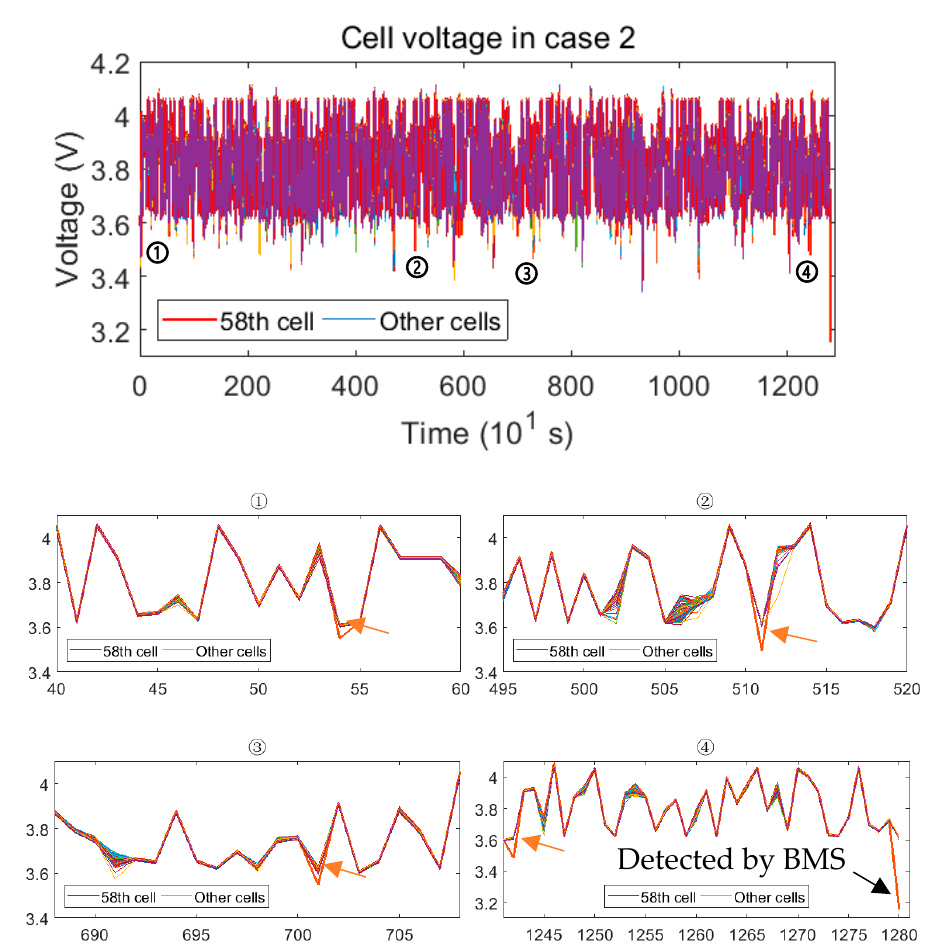
Figure 7. Voltage signal records of 90 battery cells in the second case; subplots: zoom-in of 4 concerned parts containing under-voltages (with orange arrows).